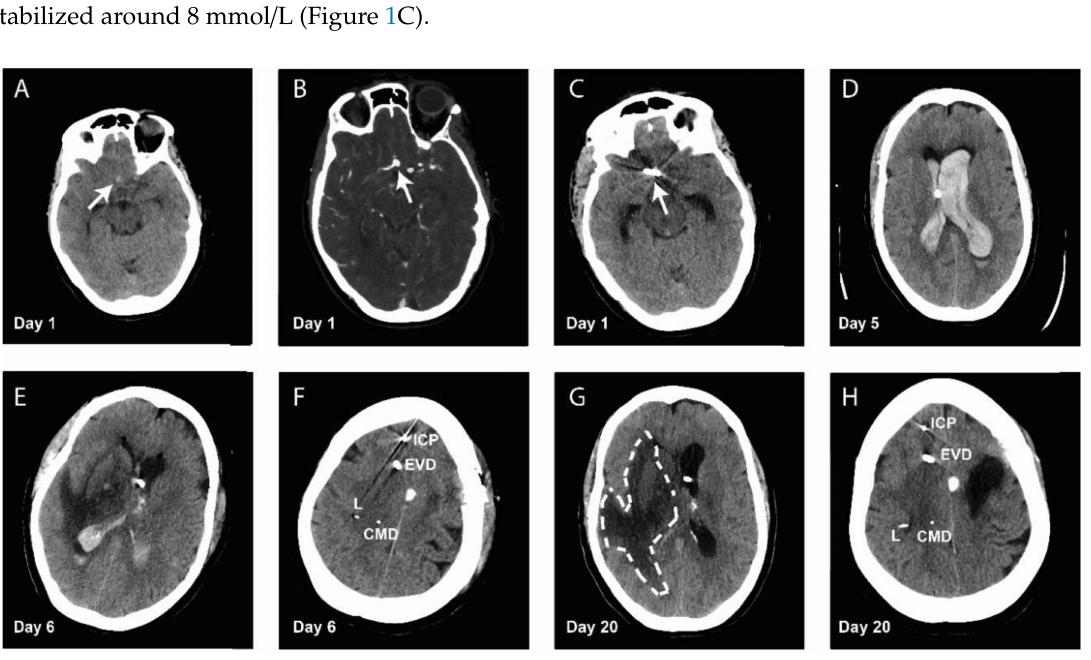
Figure 1. ( A ) CT-scan at admission showing an interhemispheric Fischer grade 1 aSAH bleeding (arrow). ( B ) CT-angiography at admission, showing the aneurism located at the right anterior communicating artery (arrow). ( C ) CT-scan showing a well-placed clip at the aneurism site after the initial